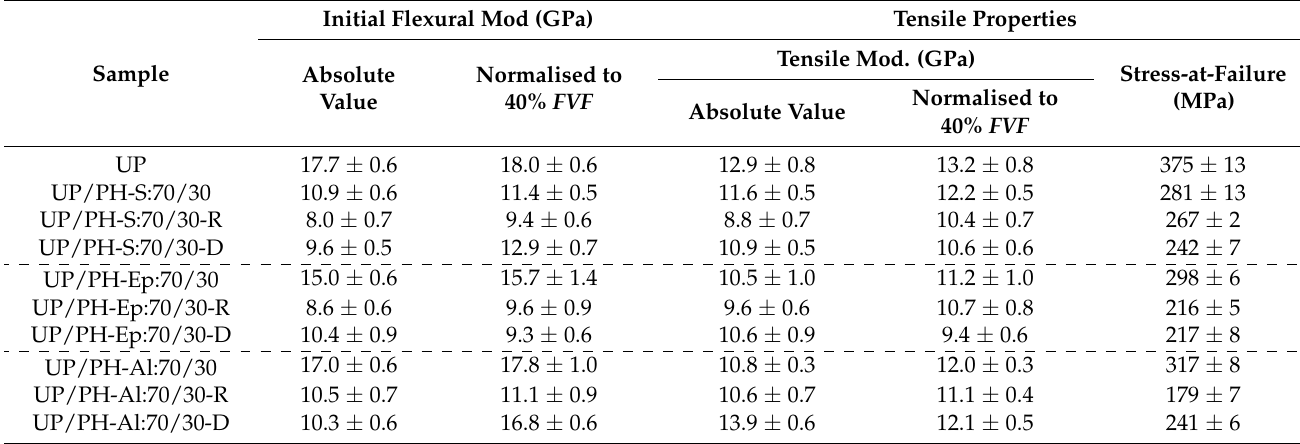
Table 4. Mechanical properties of the GFRC from UP and UP/PH with